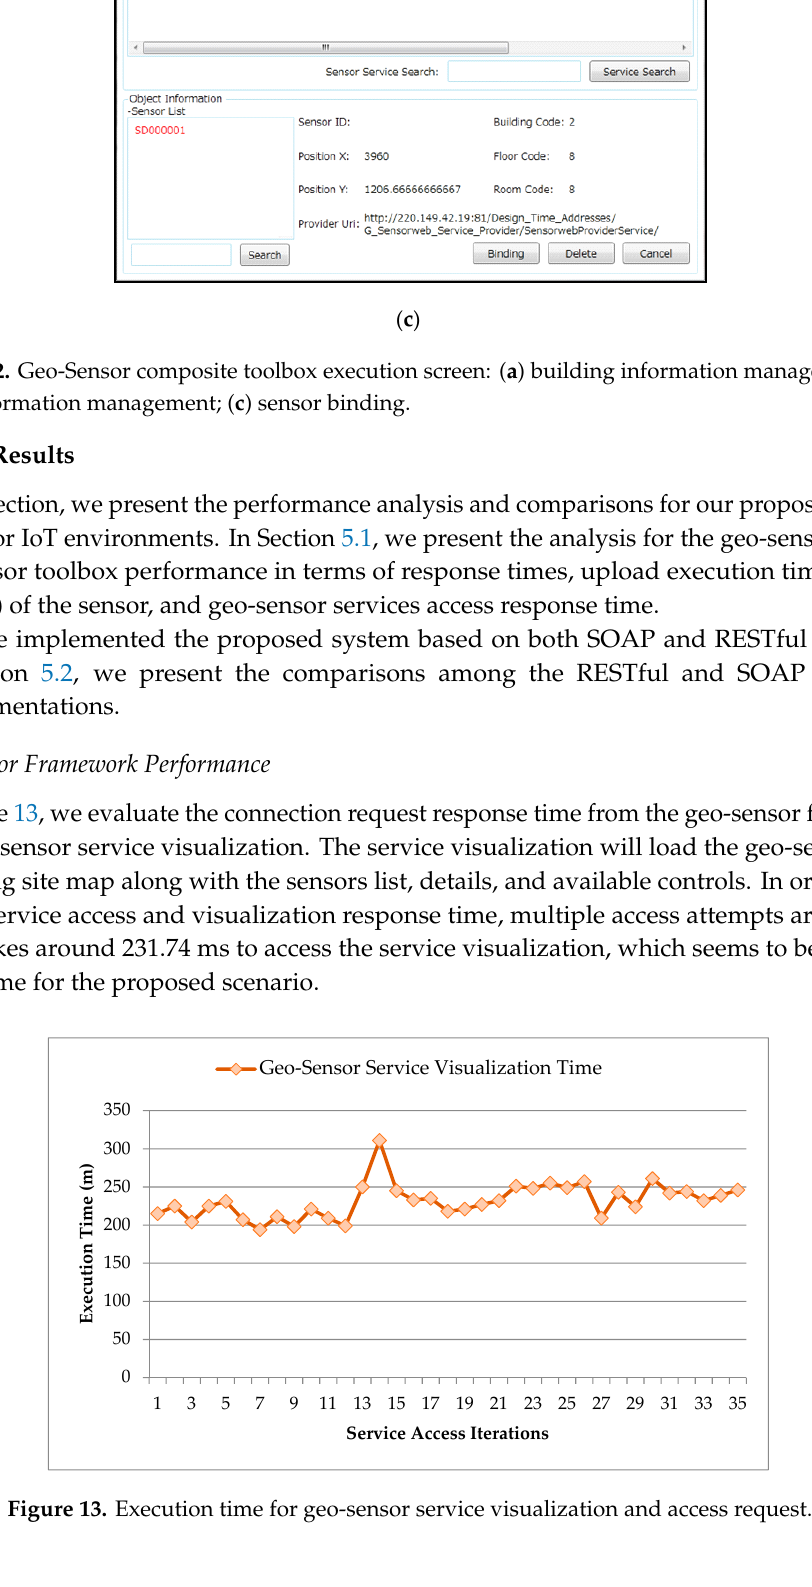
Figure 14. Execution time comparisons for loading of total map vs. mini-map. Now, we test the response time for multiple services access by multiple users at the same time to evaluate the system performance under-load scenario. Figure 15 presents the comparison of the connection request response time made from multiple users to access multiple services at the same time. The service access and visualization have to be loaded for multiple requests simultaneously in this scenario. We have evaluated multiple geo-sensor service access with a varying number of requests and varying number of active services. In the graph below, we can clearly observe that as the load of access requests and active sessions increases, the delay in responses the system witnesses, and, hence, the response time also increases. In our performed evaluation scenarios, the maximum execution time under 51 requests and 10 active users turn out to be around 3880.63 ms, and the average response time for the system under varying load scenarios turn out to be 1558.16 ms. Hence, the system response time under the worst load scenarios have delays up to a maximum of around a little less than 4 s, and on average, with varying load scenarios, remains around 1.5 s. We can safely say that the overall system performance under varying loads is tolerable, considering system service load requirements.